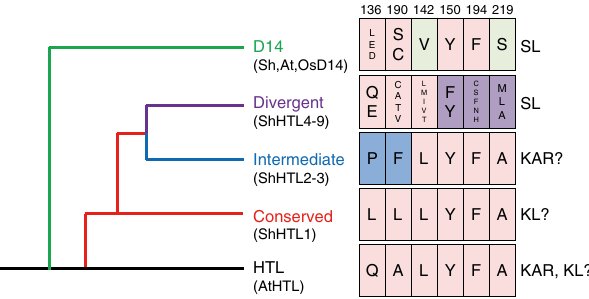
Fig. 6 Model of the evolution of HTL/D14 proteins with different ligand speci fi cities. The evolutionary model of ShHTLs was generated according to a previous model 13 with modi fi cations (left). ShHTLs of the conserved, intermediate, and divergent clades are colored red, blue, and purple, respectively. The D14 clade is colored green. The residues determining their ligand speci fi cities and the corresponding ligands are shown on the right. The residue number of ShHTL7 is shown on the